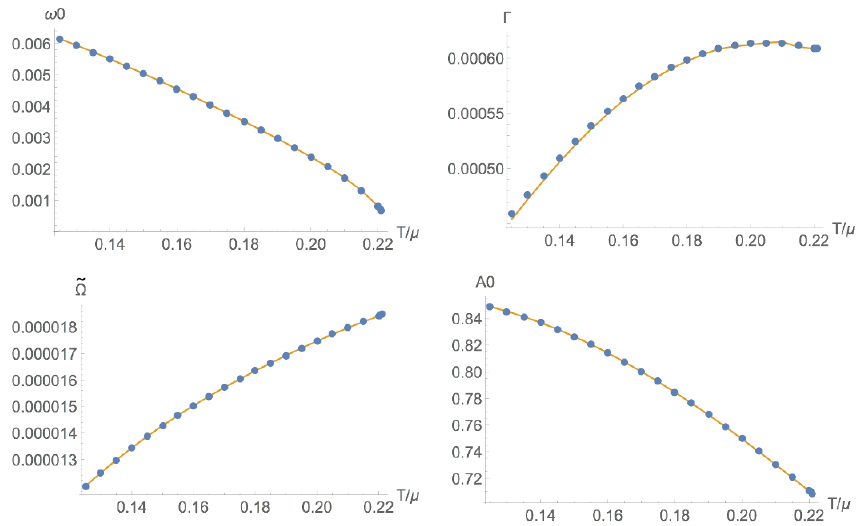
Figure 11 . Fitting parameters of the model (6.3) for pinned CDW, describing the pinned spon- taneous data (2.11) as a function of T . The data points denote the (cid:12)t parameters extracted from (cid:27) ( ! ), while the solid lines represent di(cid:11)erent cross-checks. In the case of (cid:0), ! 0 and ~(cid:10) these are the computation of the QNMs combined with the extraction of (cid:27) ( (cid:0) iw ). The solid line in A 0 was obtained from the thermodynamical quantities on the right hand side of